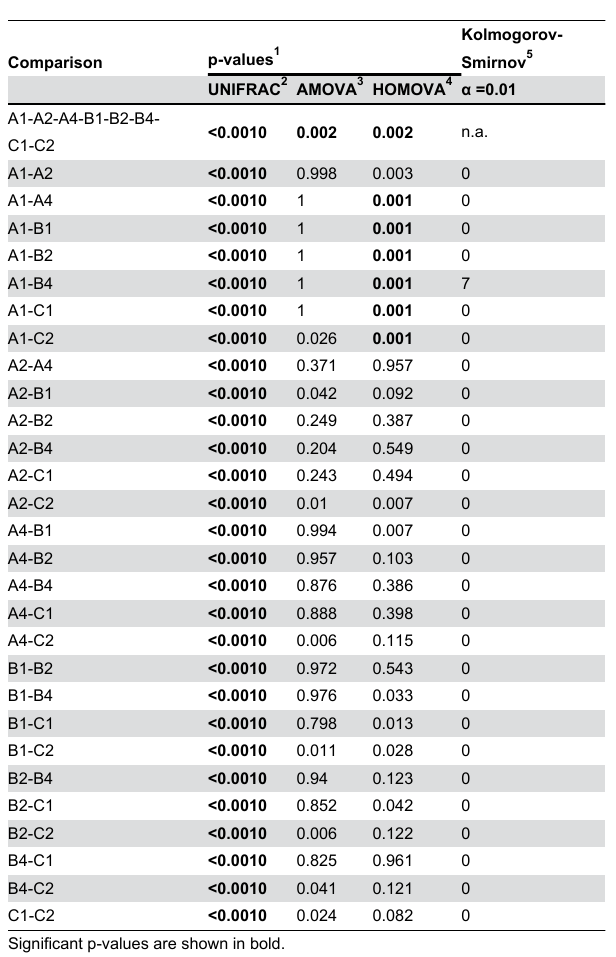
Table 2. Tests for similarity of PLS allele diversity between spores.